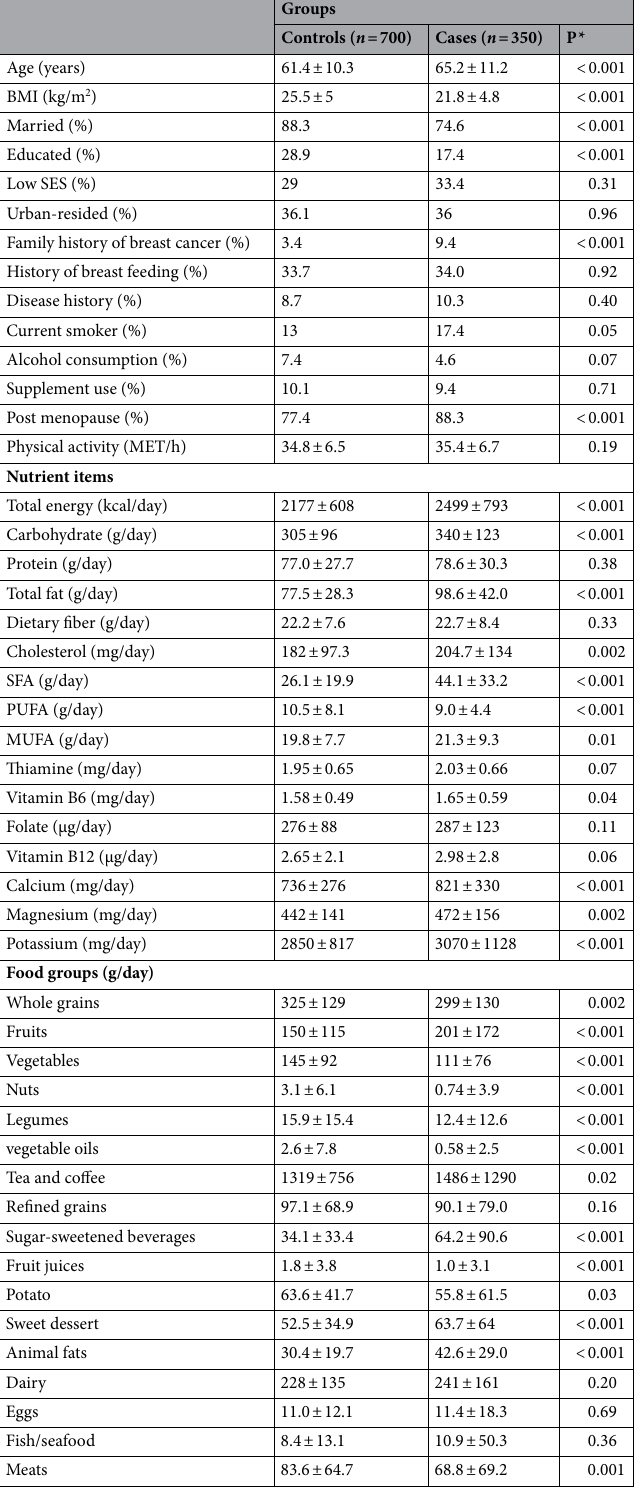
Table 1. Demographic characteristics and dietary intakes of cases and controls. All values are mean ± SD or percent. BMI body mass index, MET metabolic equivalents, SES social economic status, SFA saturated fatty acid, PUFA polyunsaturated fatty acid, MUFA monounsaturated fatty acid. *Obtained from independent sample t test or Chi-square test, where